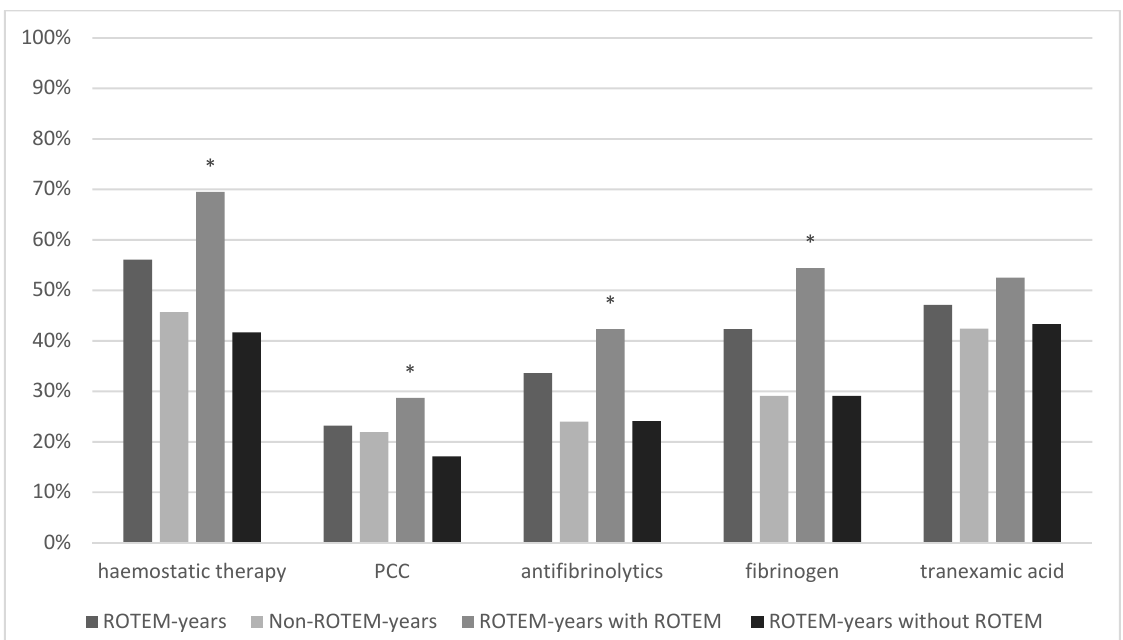
Figure 3. Haemostatic Therapy. * marks statistical significance ( p ≤ 0001).